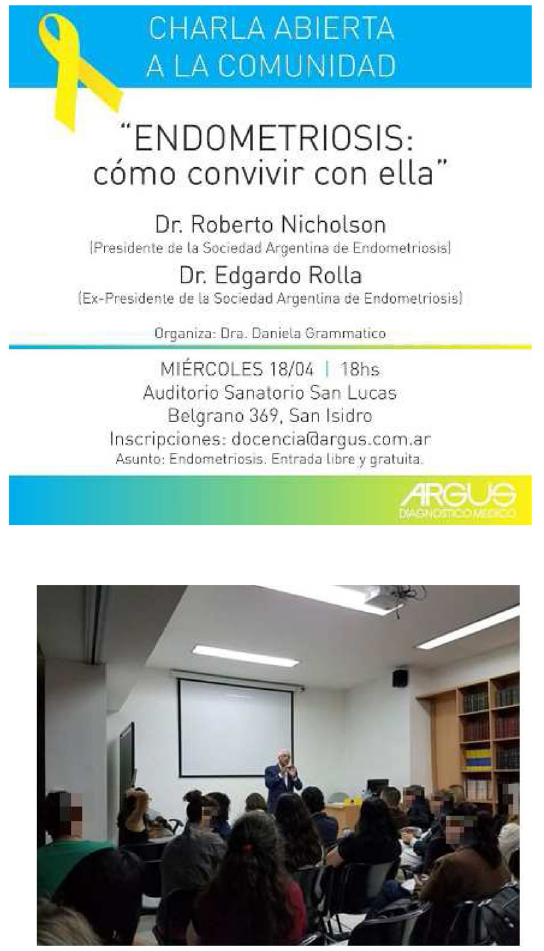
Figure 11. Poster inviting the public to attend a conference on endometriosis and a photo from the conference. Photo by the author.